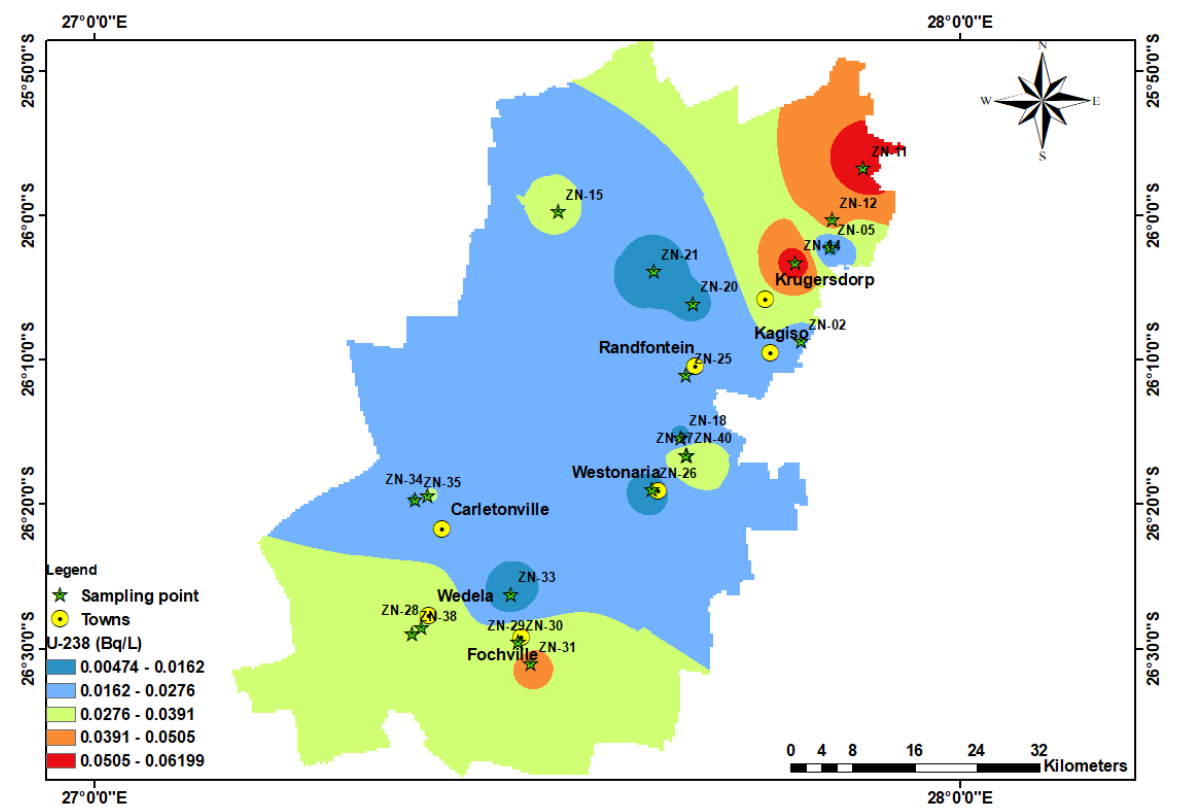
238 U in the West Rand